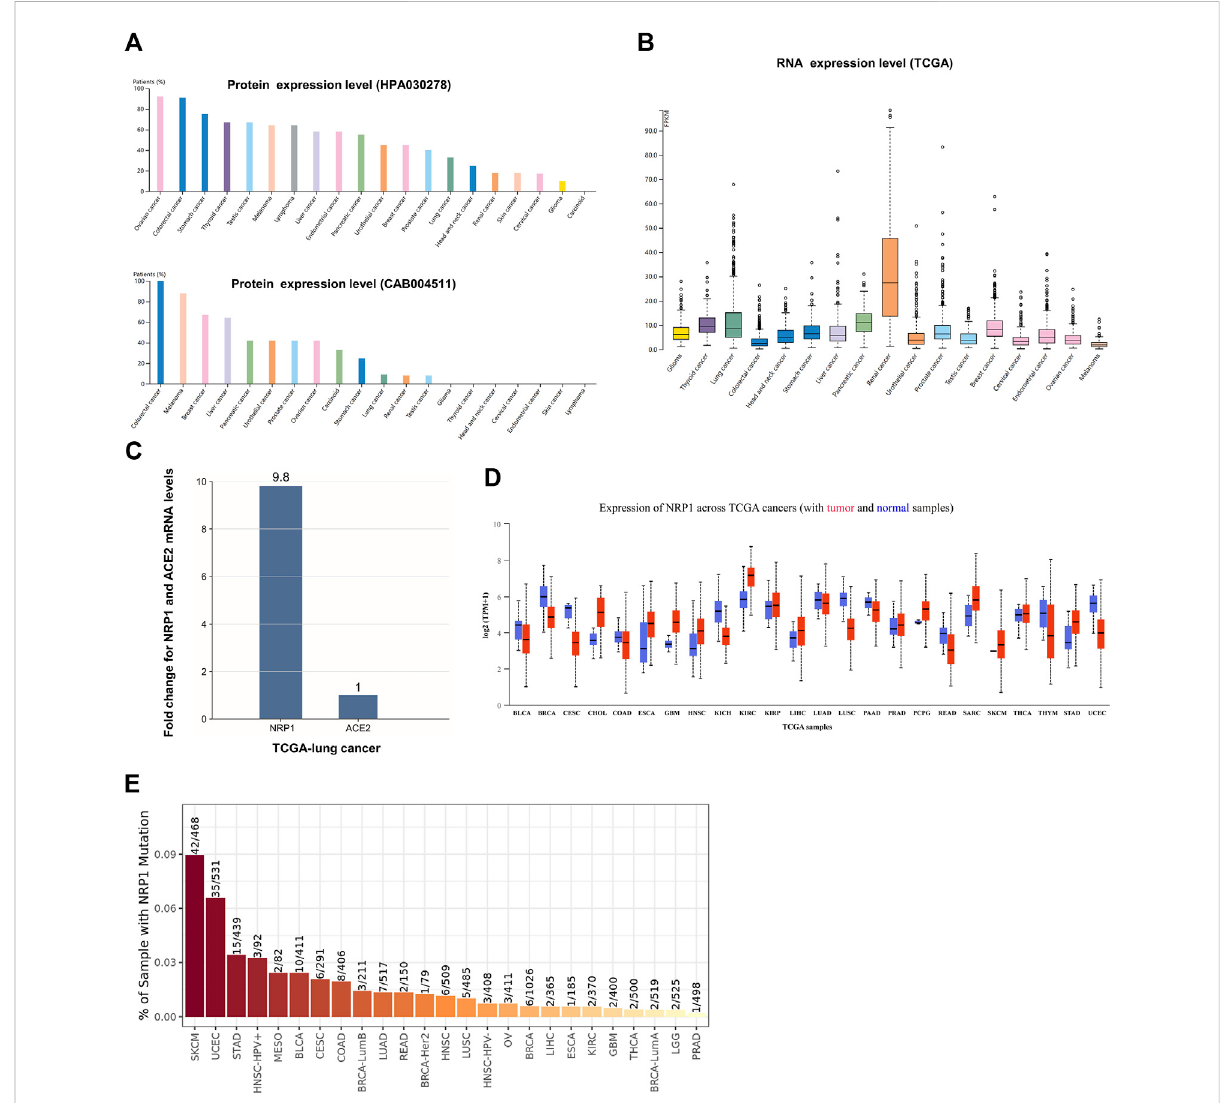
NRP1 expression in different cancer types (A) The protein expression pro fi le of NRP1 ranked by expression levels. NRP1 proteins were detected byHPA030278andCAB004511respectively. (B) Thepan-cancerRNAexpressionpro fi leofNRP1intheTCGAdataset (C) ThemRNAexpressionlevel of NRP1 relative to that of ACE2 in the TCGA-lung cancer tissues. (D) The mRNA expression pro fi le of NRP1 in tumor and normal samples across TCGA cancers. (E) Bar plot presenting NRP1 mutation frequency in the indicated TCGA cancer